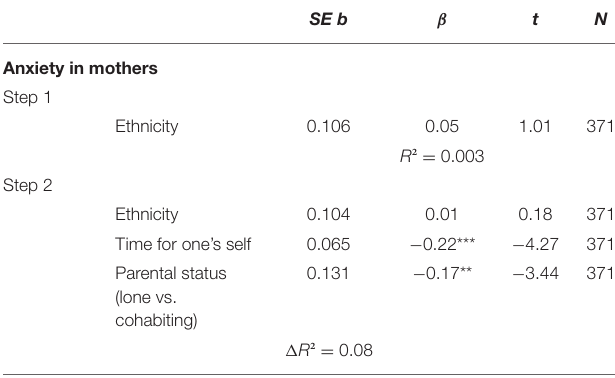
TABLE 6 | Hierarchical regression analyses predicting anxiety in